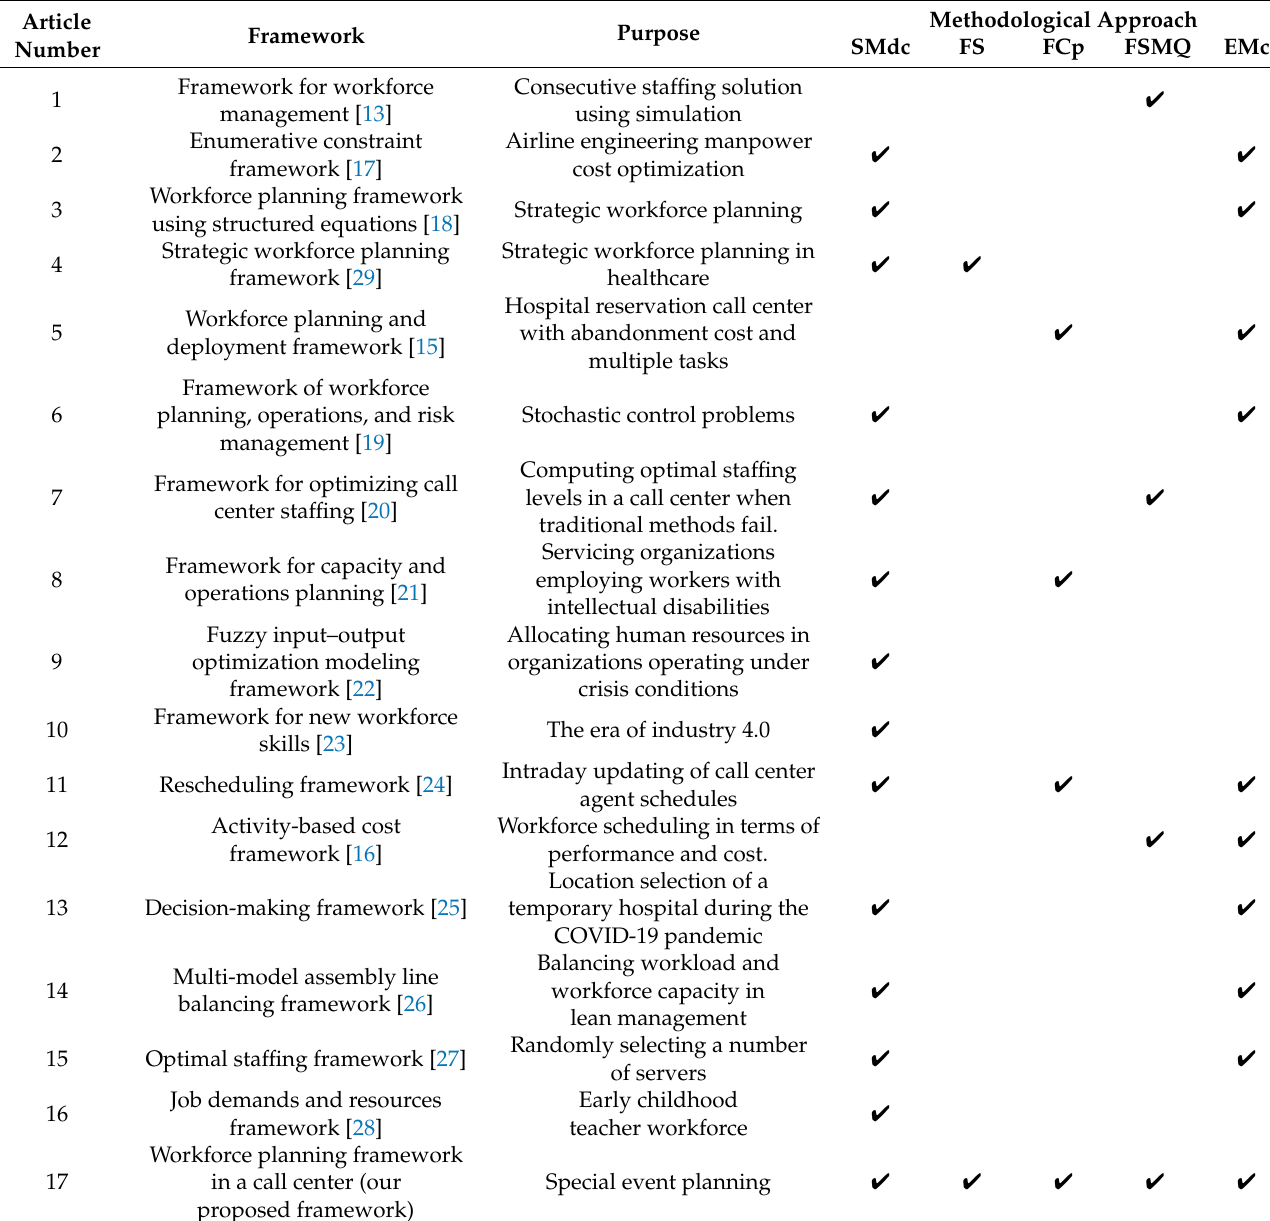
Table 1. Comparison of the related framework methodological approach with the proposed